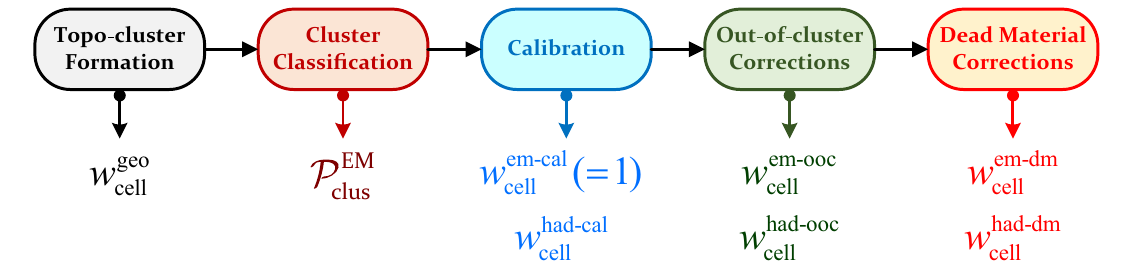
Fig. 9 Overview of the local hadronic cell-weighting (LCW) calibra- tion scheme for topo-clusters. Following the topo-cluster formation, the likelihood for a cluster to be generated by electromagnetic energy deposit ( P EM ) is calculated. After this, the sequence of calibration and clus corrections indicated in the schematics is executed, each yielding cell